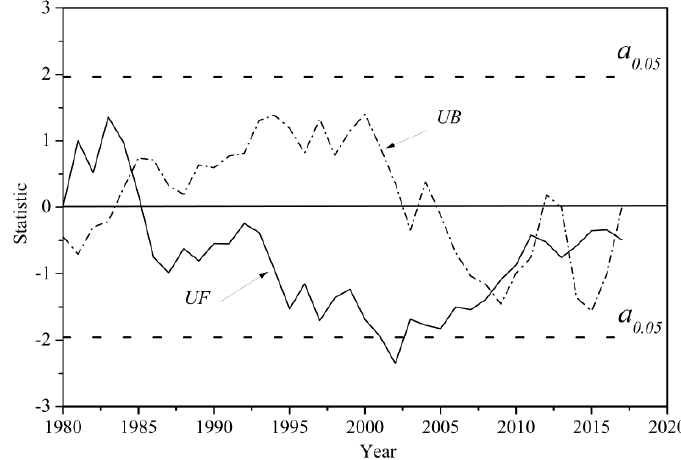
Figure 4. Mean annual rainfall M – K statistic curve. UF refers to the normal statistics (1980 – 2017). UB is reverse order of − UF as an auxiliary line. α 0.05 refers to 95% confidence limit.